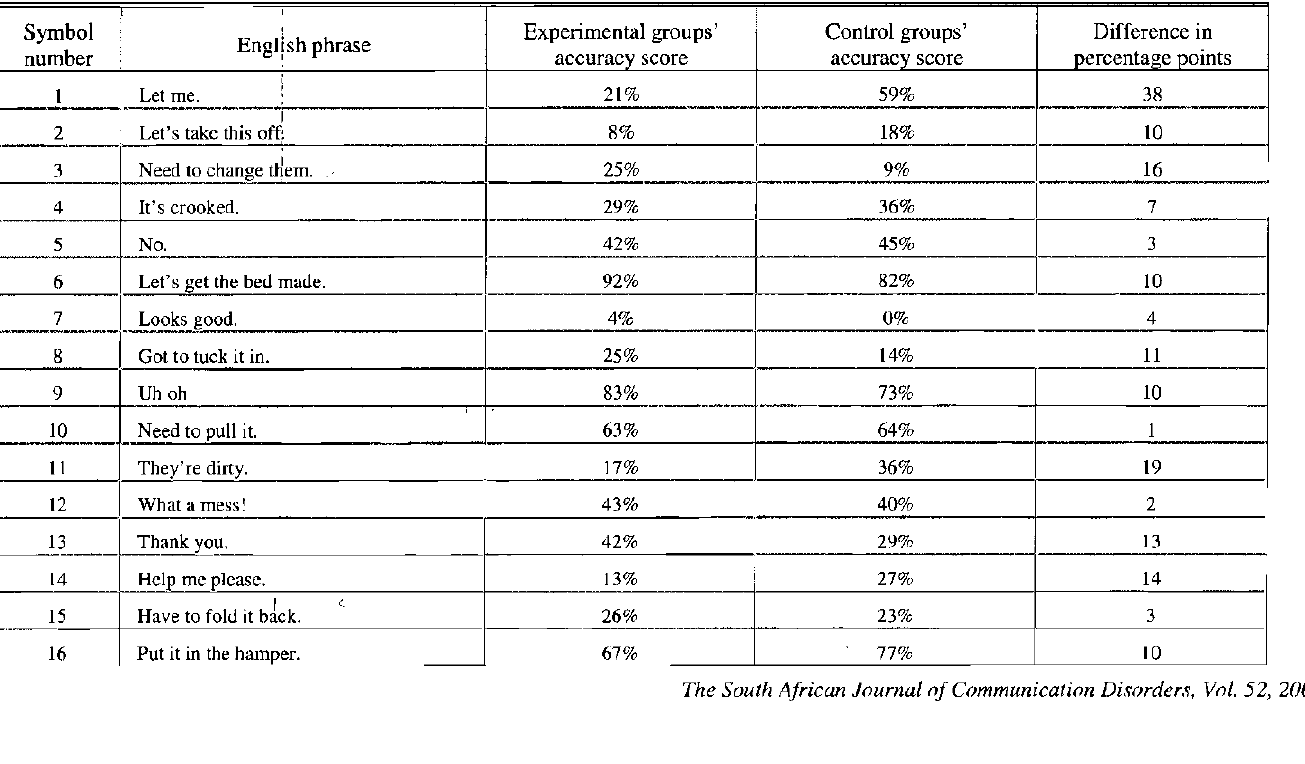
Table 2. A comparison between the experimental and coi